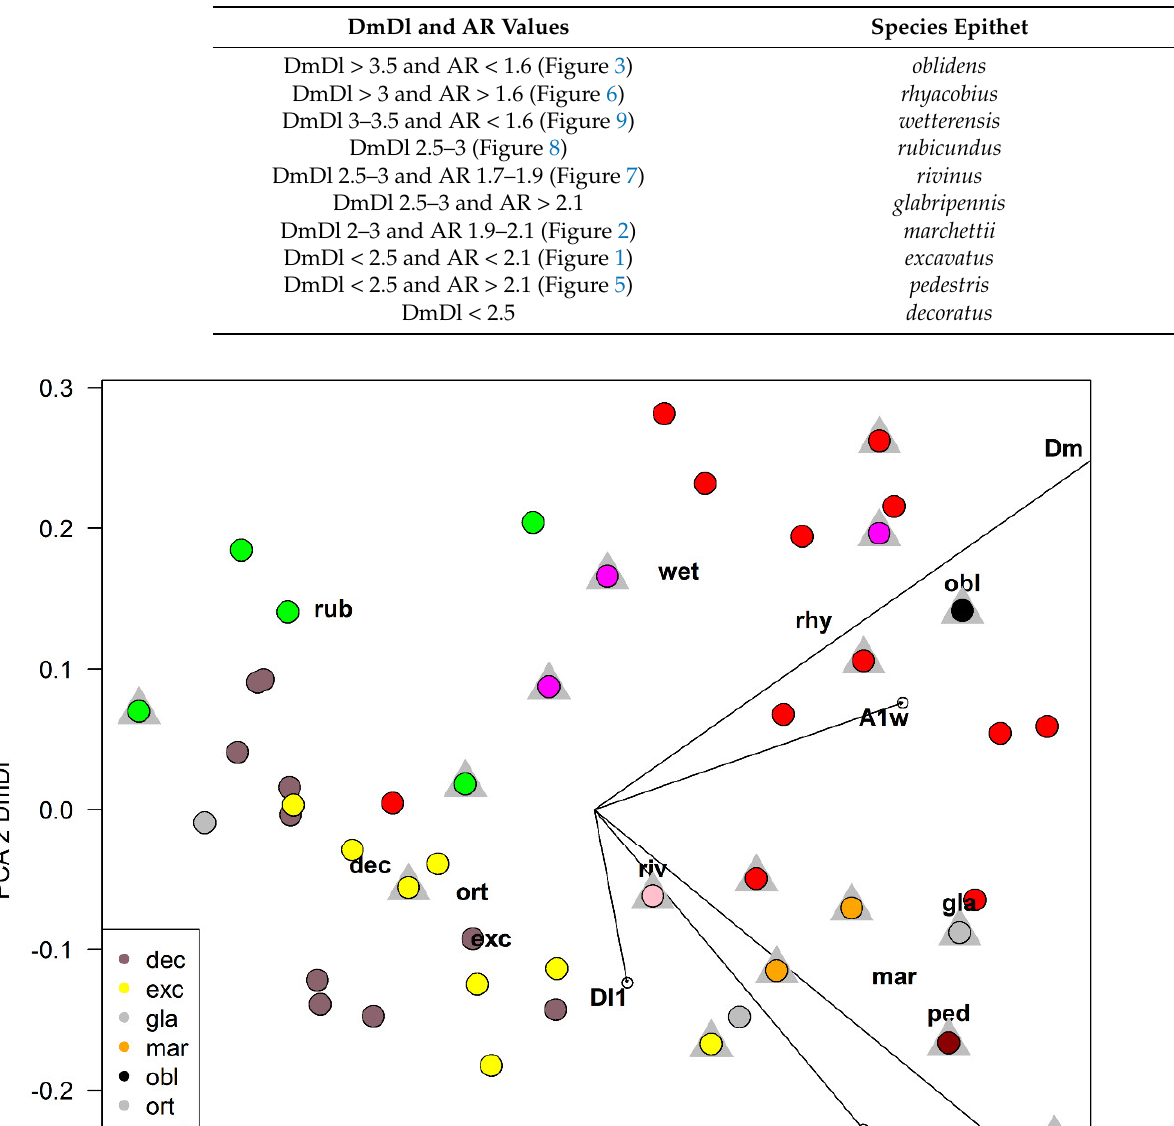
Table 6. DmDl and AR values useful to separate larvae.